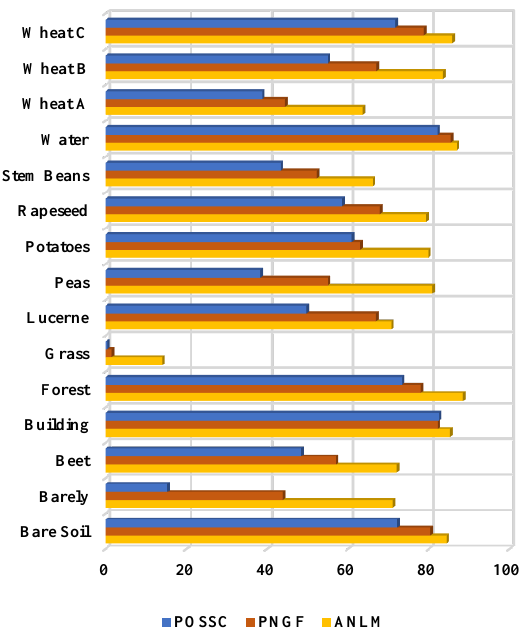
Figure 6. Comparison of Producer’s accuracy based on various croplands obtained by different de-speckling methods.